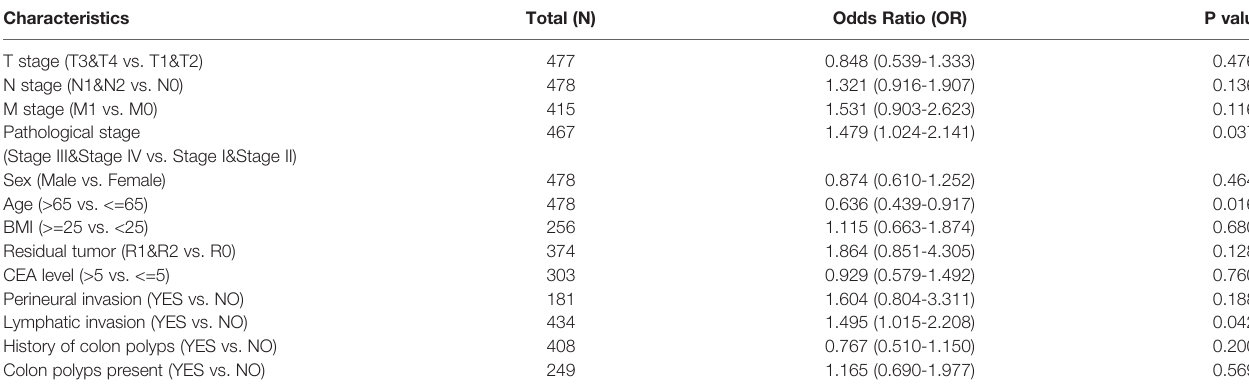
TABLE 2 | The relationship between increased MPO expression and clinicopathological features by logistic regression.